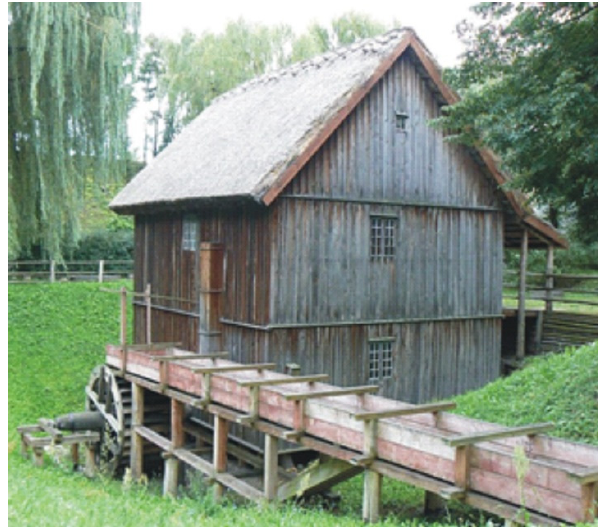
Figure 2. The water in the Ethnographic Museum in Toru ń (photography: B. Igli ń ski).